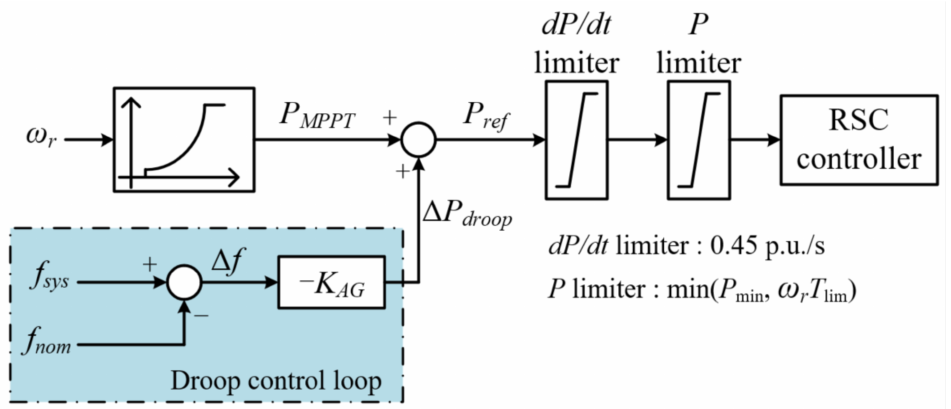
Figure 2. Control concept of the droop